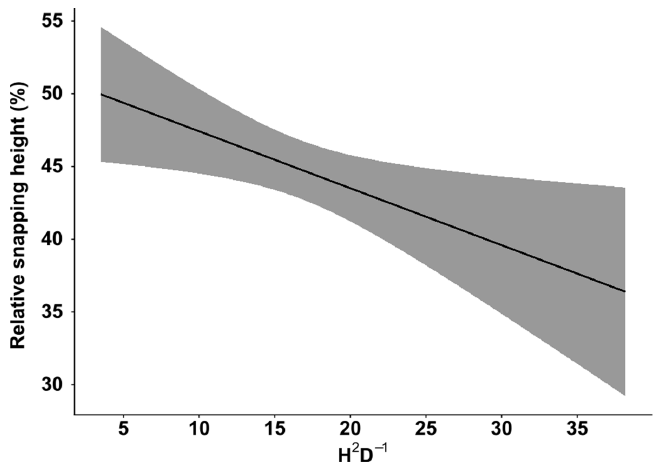
Figure 5. The influence of the slenderness ratio (h 2 /d) on relative snapping height (%). The grey area represents the ±95% confidence interval.